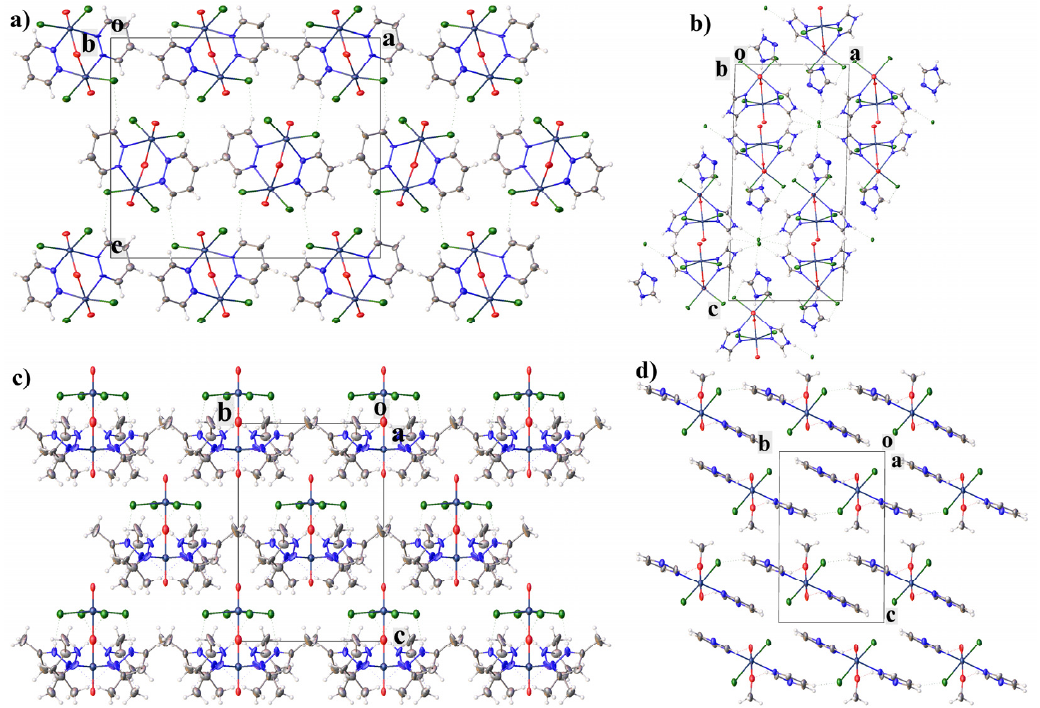
Figure 2. Crystal packing of 1 ( a ), 2 ( b ), 3 ( c ) and 4 ( d ) showing the complexes’ layers.